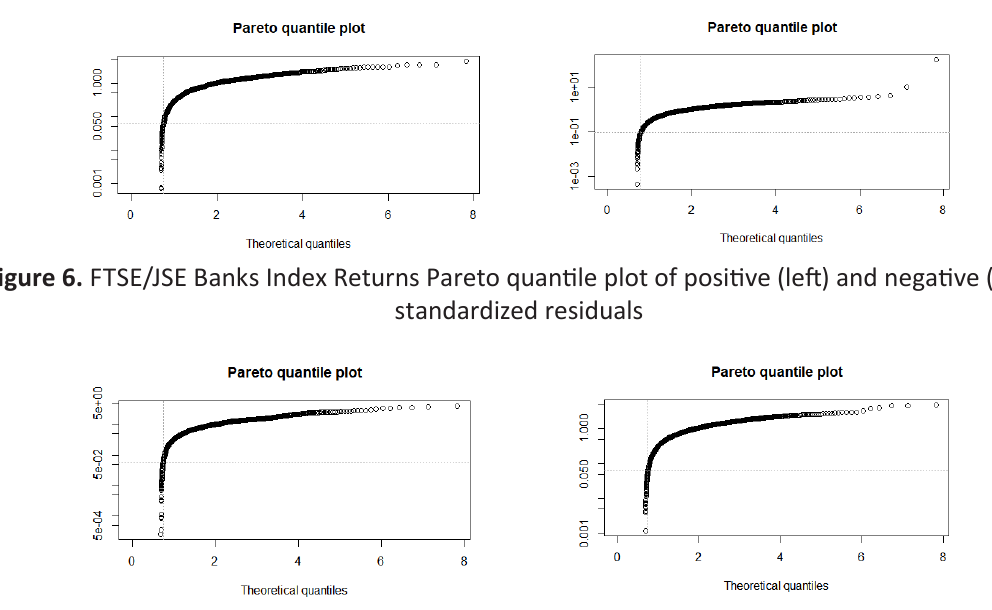
Figure 5. FTSE/JSE ALSI Returns Pareto quantile plot of positive (left) and negative (right) standardized residuals